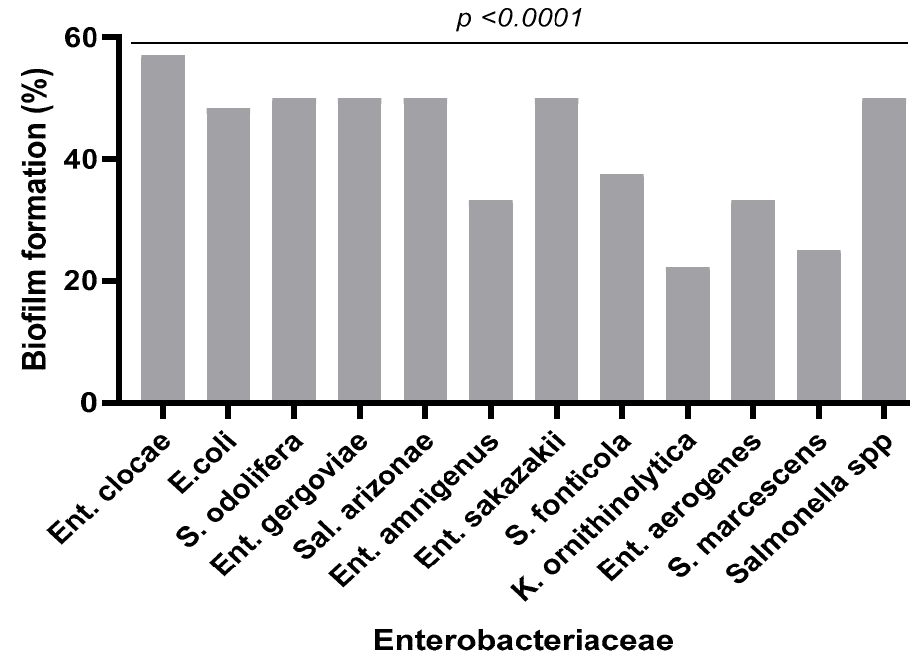
Figure 4. Biofilm production rate by bacterial species.